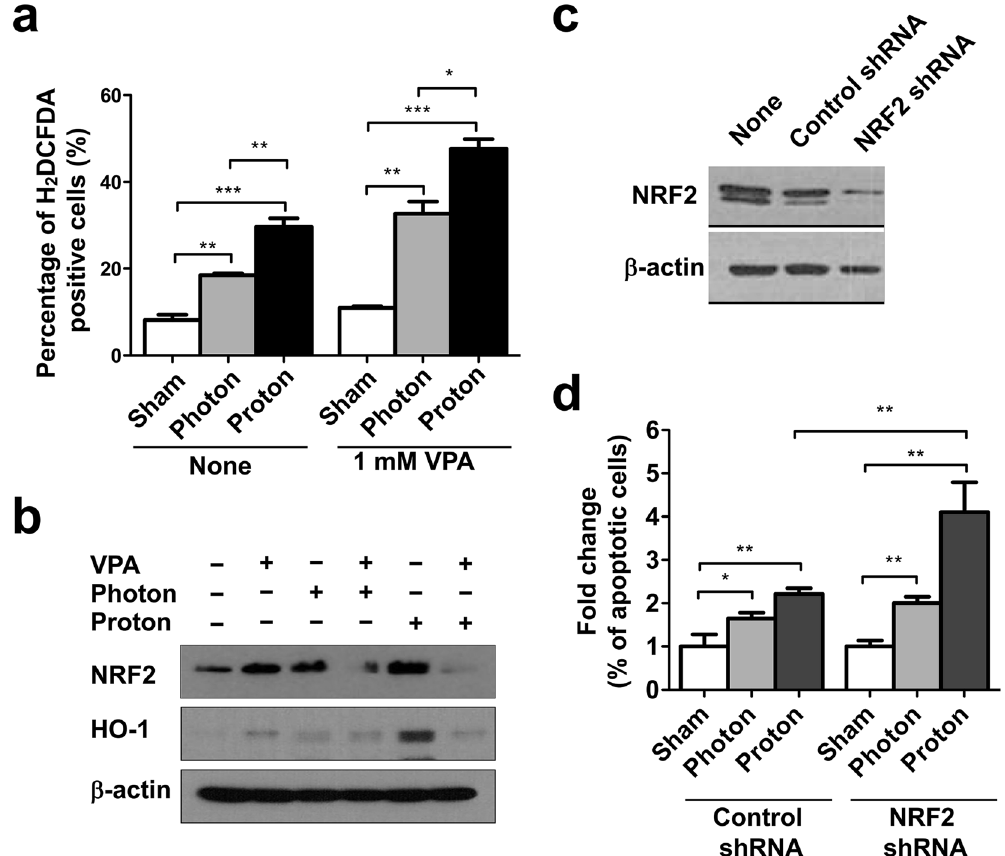
Figure 6. VPA enhances proton-induced ROS production and suppresses activation of NRF2 signaling in Hep3B cells. ( a ) Production of ROS in 6 Gy photon or proton-irradiated cells was measured using H2DCADA fluorescence dye. Data are mean values ± SD of three samples. * p < 0.05, ** p < 0.01, *** p < 0.001. ( b ) Western blot analysis showed VPA suppressed proton-mediated upregulation of NRF-2 and its downstream HO-1. ( c ) Western blot analysis confirmed shRNA-mediated depletion of NRF2 in Hep3B. GFP shRNA was used as a control shRNA. ( d ) Apoptosis assay using flow cytometry with annexin V revealed proton irradiation induced more apoptosis of NRF2-depleted cells than control cells. Data are mean values ± SD of three samples. * p < 0.05, ** p < 0.01, *** p < 0.001. The cropped blots are presented and their full-length blots are included in the Supplementary Fig.